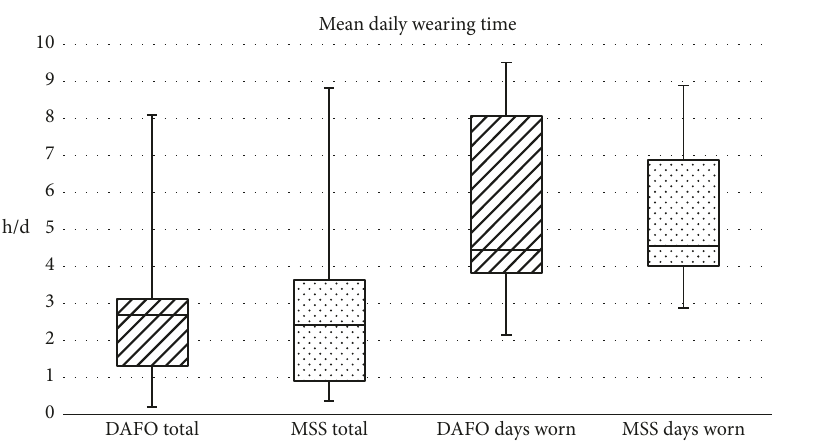
Figure 2: Mean daily wearing time for DAFOs and MSS in total and for the days